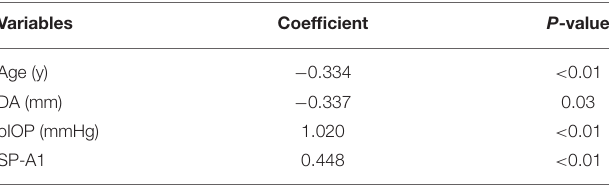
FIGURE 2 | The mean anterior chamber volume (ACV) in primary angle closure (PAC) patients was significantly shallower than in normal